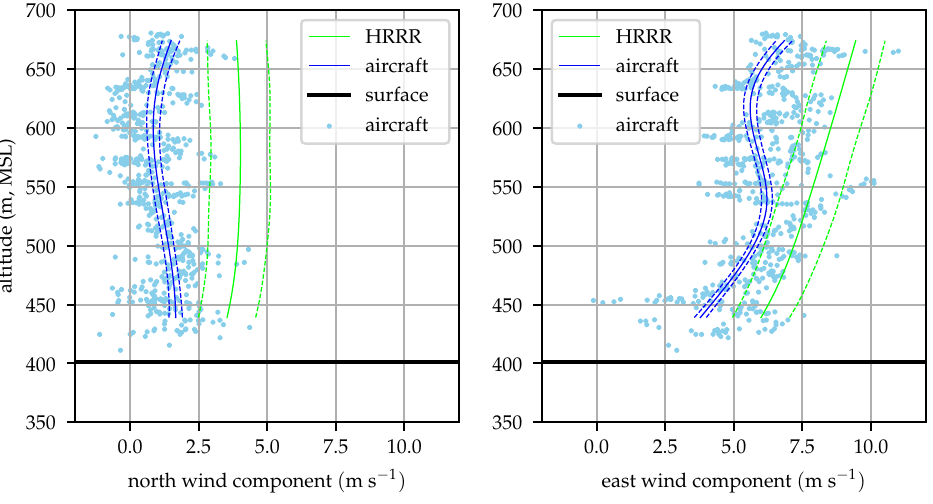
Figure 18. Aircraft measured and HRRR predicted wind profiles at 08:00 local time